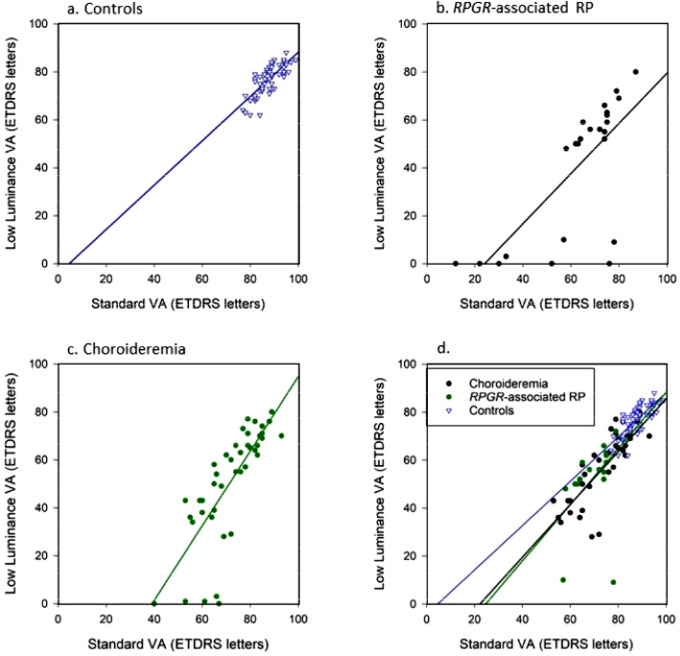
Spearman rank significant positive correlations between standard VA and LLVA: (a) controls (ρ = 0.81, P < 0.001), (b) patients with RPGR-associated RP (ρ = 0.72, P < 0.001), and (c) patients with choroideremia (ρ = 0.85, P < 0.001). (d) Subanalysis after choroideremia and RPGR-associated RP zero LLVA values are removed. The blue trend line represents controls, the solid black trend line represents RPGR-associated RP, and the dotted green line represents the choroideremia trend line.